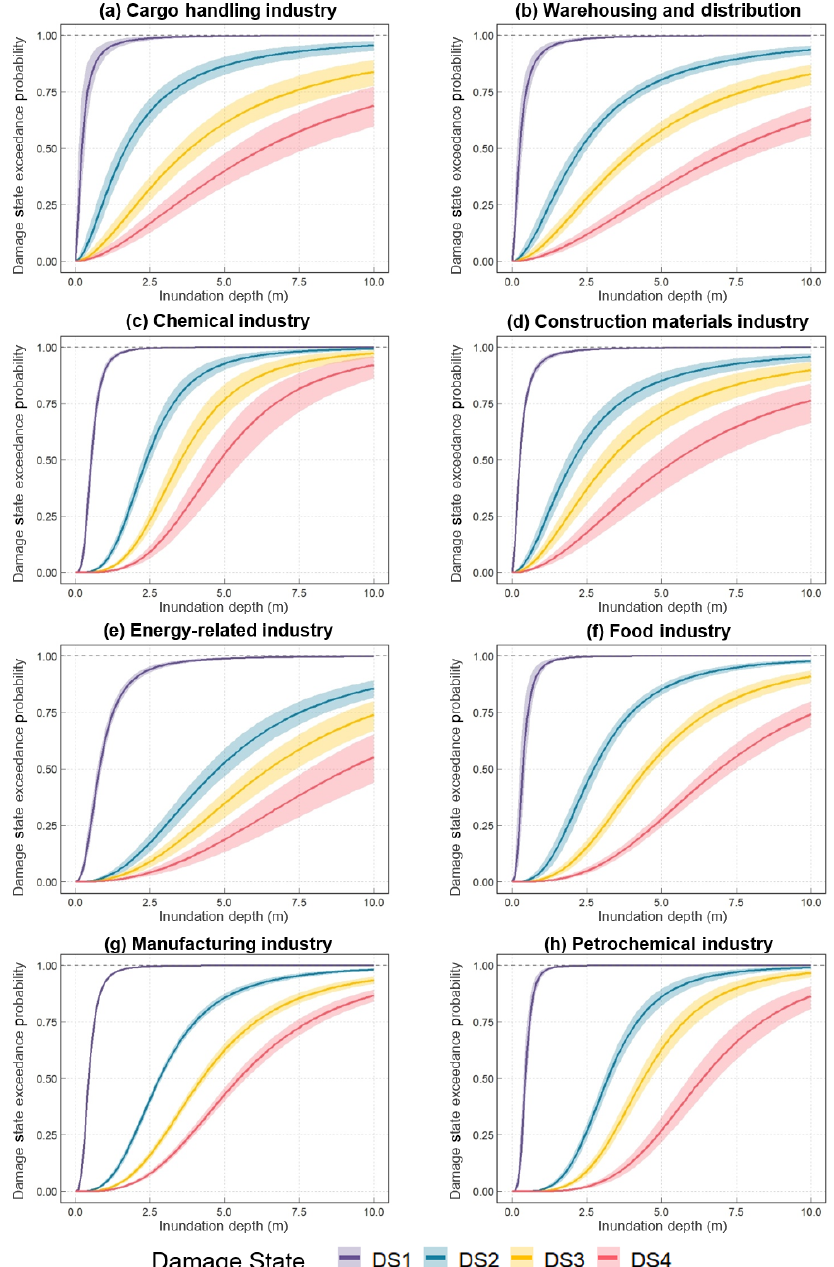
Figure 8. Fragility curves with 95% confidence bands for port industries identified in this study. Chemical, cargo handling and construction material industries appear to be more vulnerable to tsunami inundation depths, while petrochemical and warehousing and distribution indus- tries have lower damage probabilities for the same inundation depths. Wider confidence bands imply greater variability in uncertainty and could be results of smaller sample